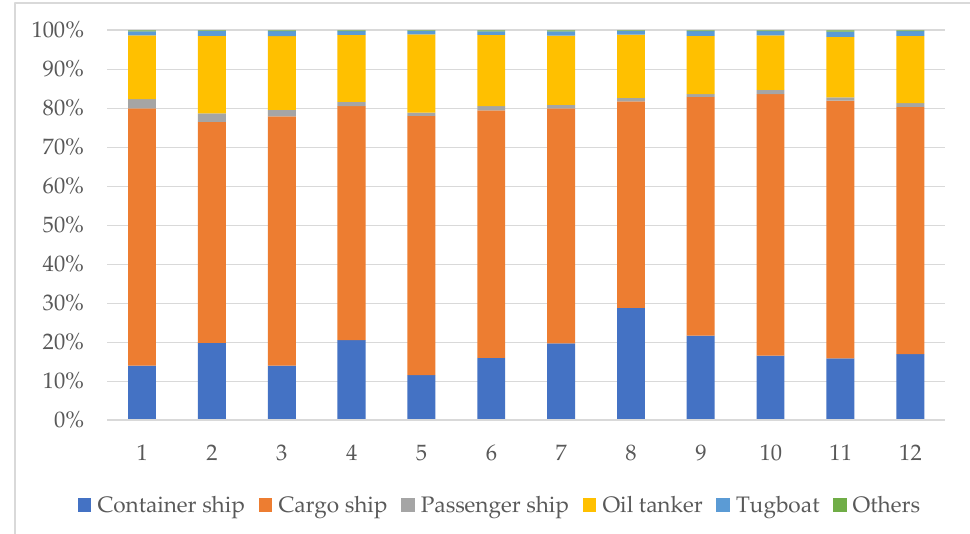
Figure 2. Monthly distribution of AIS data records for each ship type.